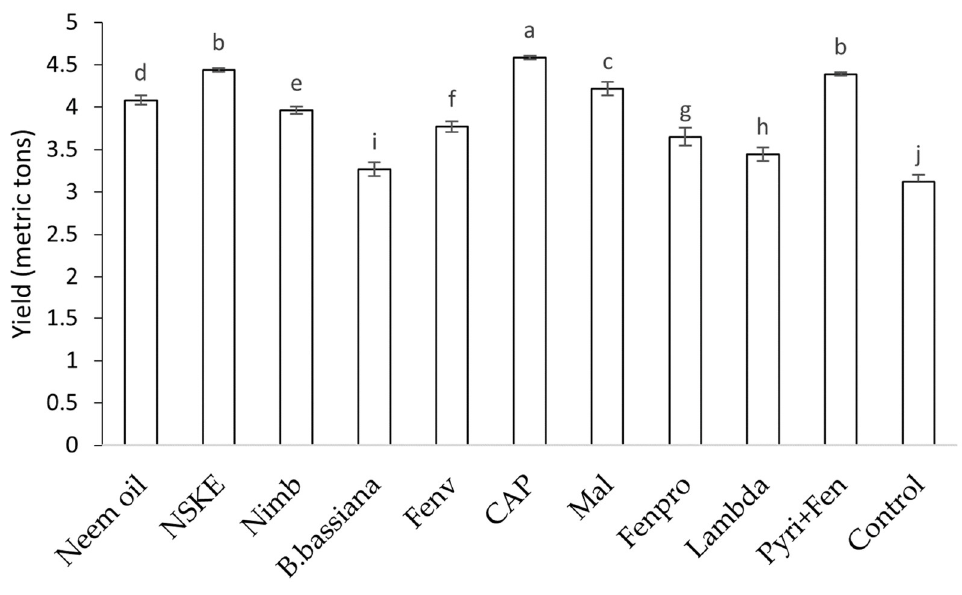
Figure 1. Yield, expressed as metric tons per hectare (q/ha), obtained from the 11 treatment plots (10 insecticides and a no insecticide control). The columns represent the mean values and error bars denote the standard error (mean ± SE). Bars with a different letter indicates that the treatments are significantly different based on Fisher’s LSD at α = 0.05. Here, NSKE = Neem Seed Kernal Extract; Nimb = Nimbicidine; B. bassiana = Beauveria bassiana ; Fenv = Fenvalerate; CAP = Chlorantraniliprole; Mal = Malathion; Fenpro = Fenpropathrin; Lambda = Lambda-cyhalothrin; Pyri+Fen = Pyriproxyfen 5% EC+ fenpropathrin 15% EC.